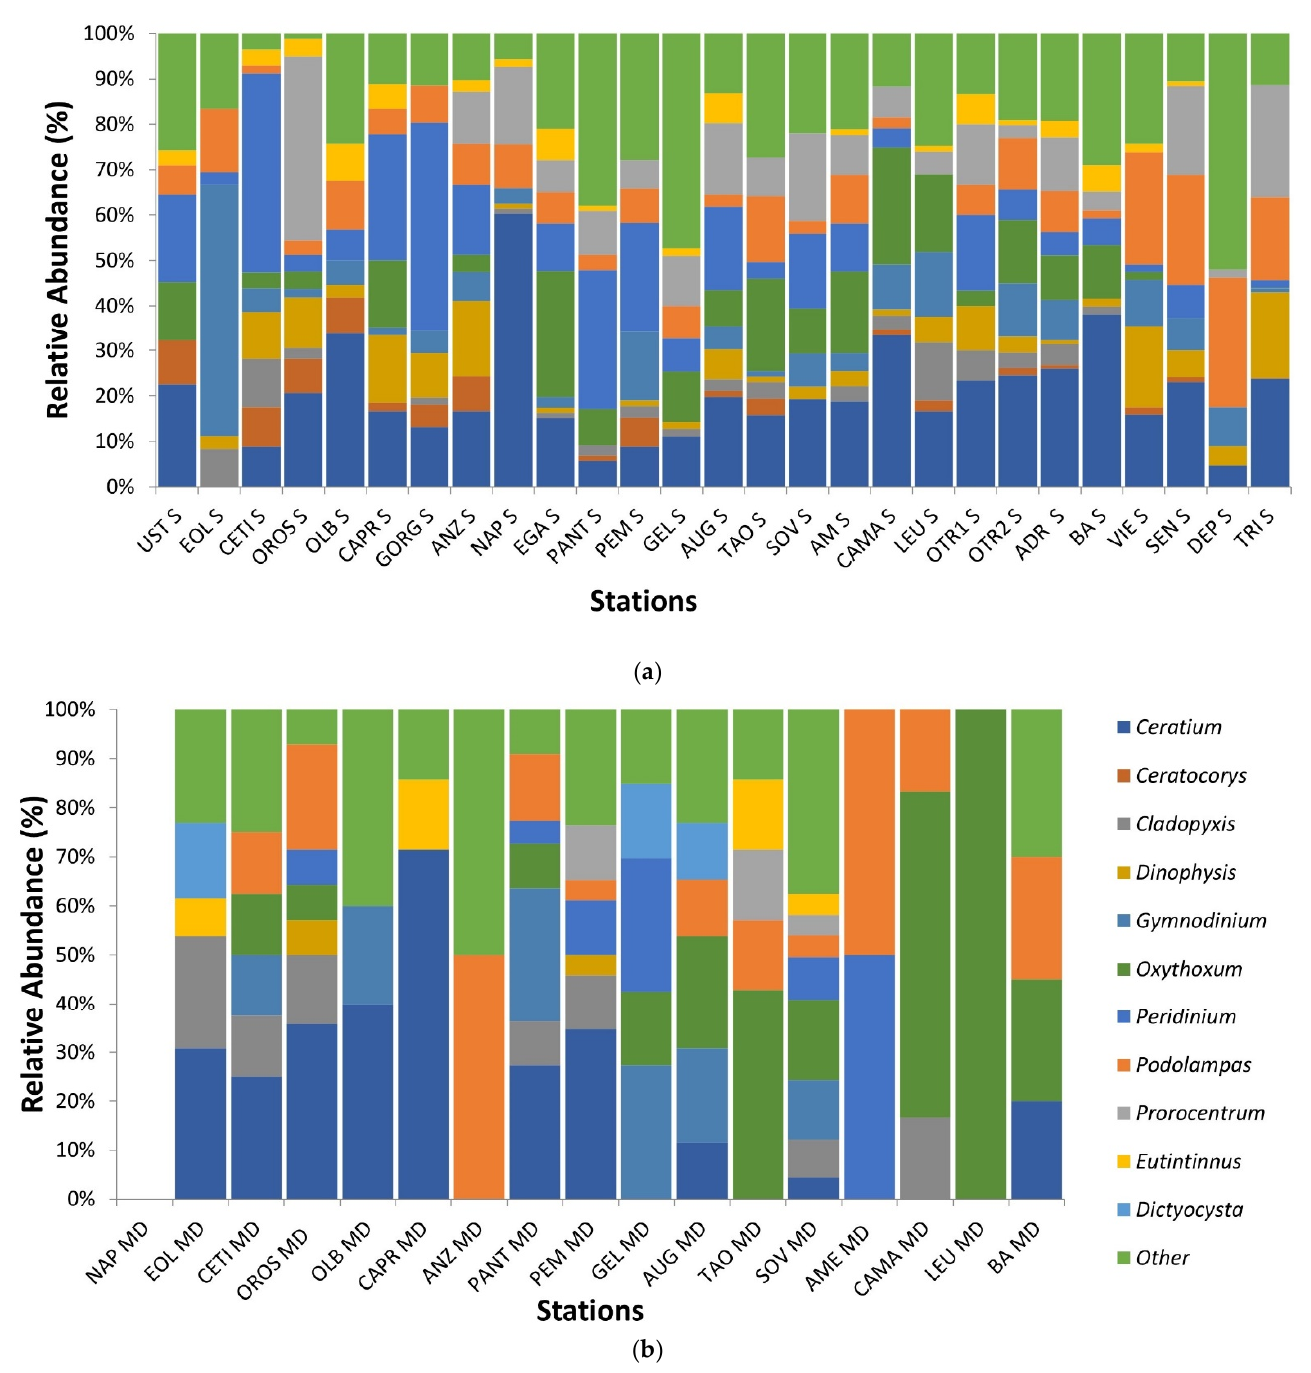
Figure 7. Relative abundances (%) of the main 10 taxa identified in samples collected in 2017 divided by ( a ) Epipelagic (2–4 m below the sea level) and ( b ) Mesopelagic (200–500 m below the sea level) layers 2017. Remaining genera were grouped in Other.